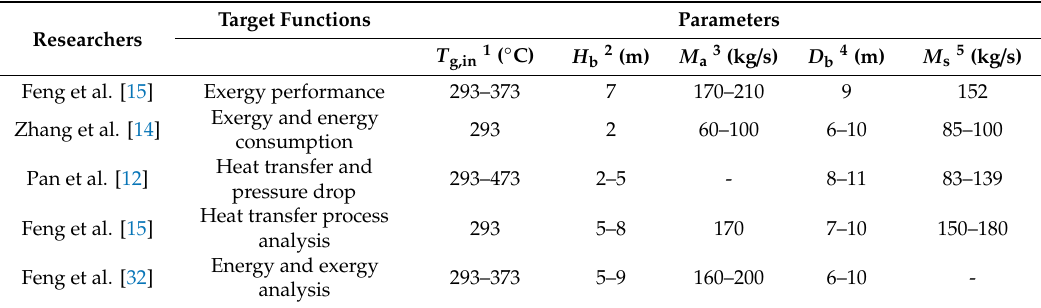
Table 1. Parameters of interest for the heat transfer process in published